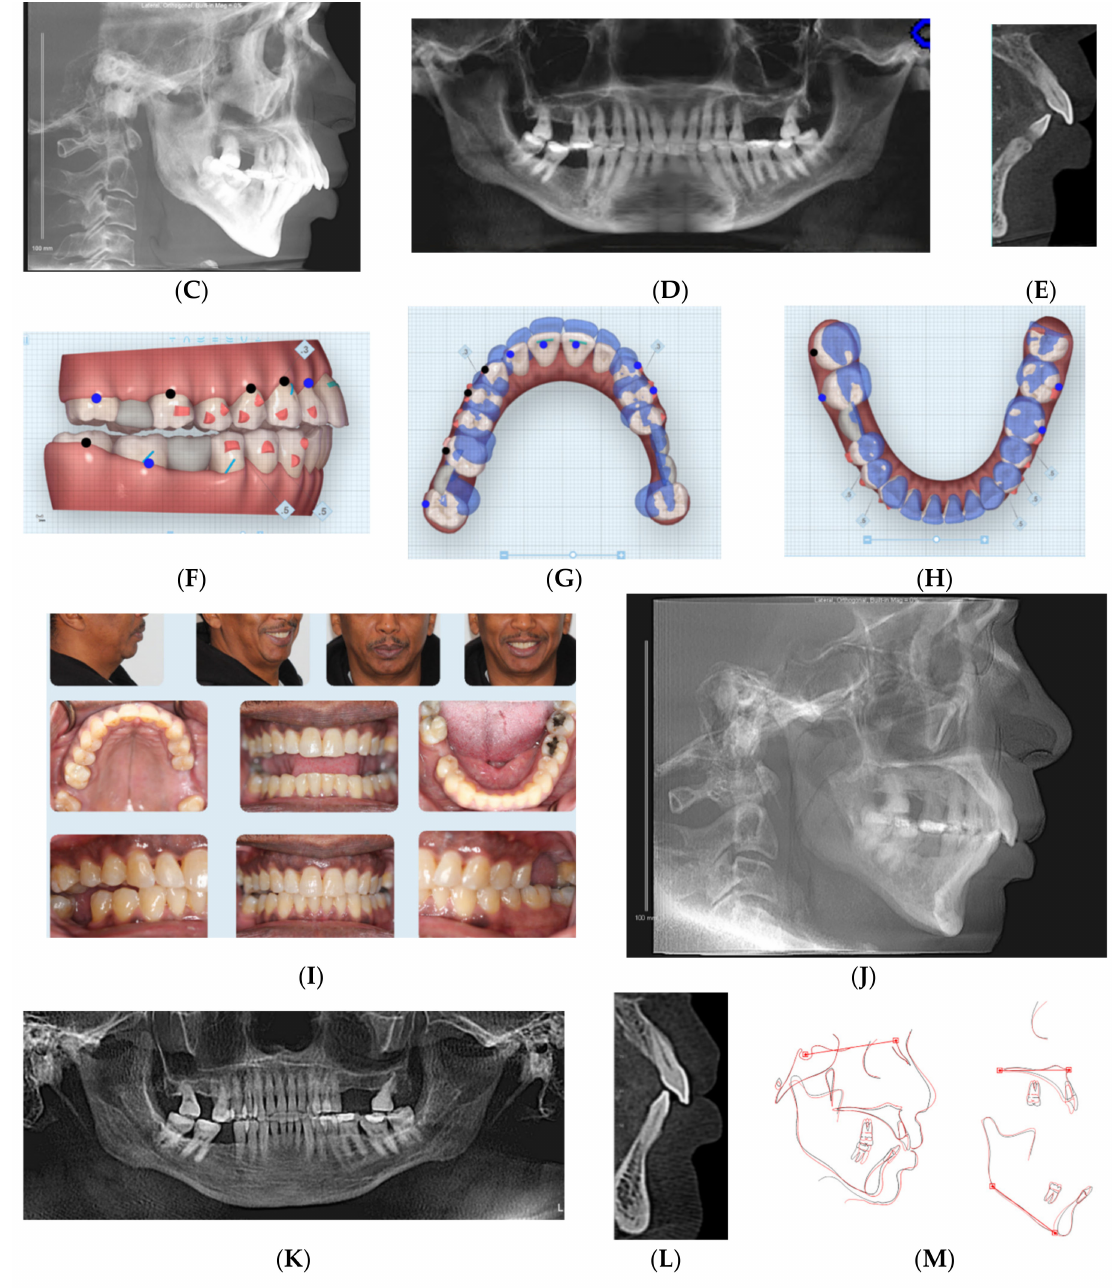
Figure 2. ( A ) Initial photographs showing convex profile with recessive chin and anterior crowding. ( B ) Initial digital models showing left side Class II buccal occlusion with a 7 mm increased overjet. ( C ) CBCT-driven cephalometric radiograph showing convex profile with recessive chin and protrusive upper incisors. ( D ) CBCT panoramic radiograph showing missing 1.7, 2.6, 2.7, and 4.6 molars; no other noticeable intraoral bony lesion could be detected. ( E ) CBCT-driven sagittal screen of lower incisor showing its severe proclination with minimum bone appears on most of the labial surface of the root and compromised crown / root ratios. ( F ) Digital treatment plan (ClinCheck) showing posterior teeth intrusion to help forward rotation of the mandible palatal root torque of upper incisors. ( G ) Upper arch digital treatment plan (ClinCheck) showing expansion (blue—initial teeth position, white—final teeth position) and retraction of upper incisors to improve their initial protrusion. ( H ) Lower arch